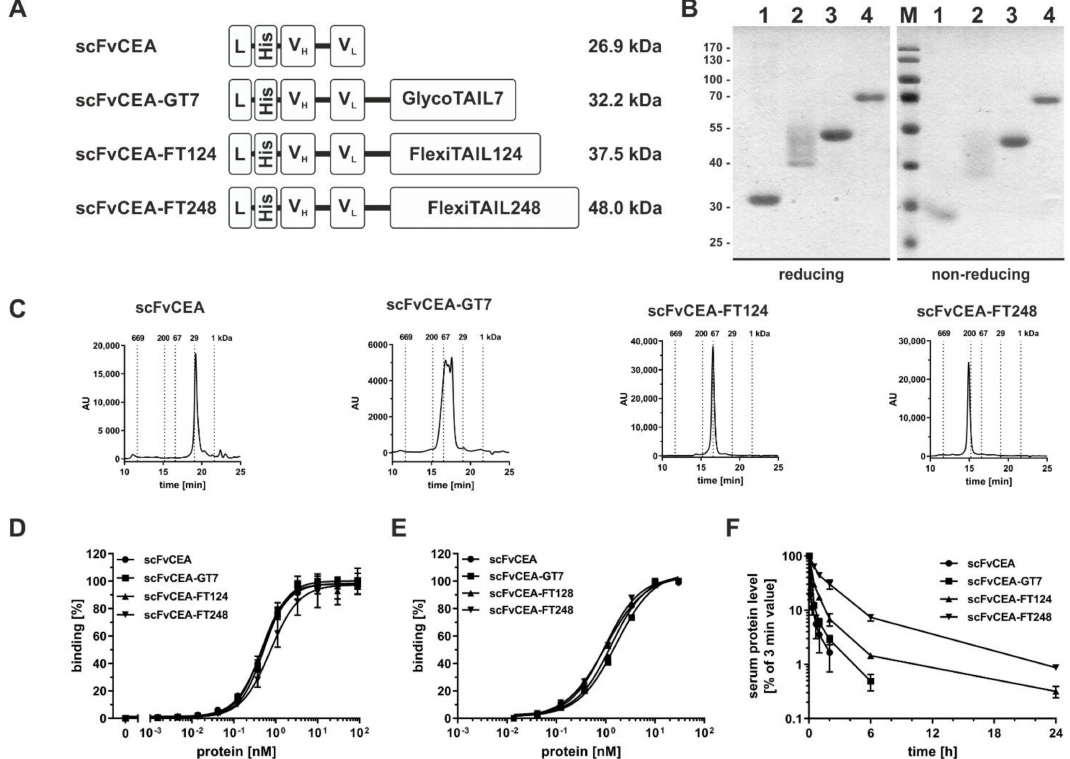
Figure 2. Analysis of scFvCEA-based antibody molecules. ( A ) Schematic illustration of the mono- valent scFvCEA molecules comprising C-terminal GlycoTAIL or a FlexiTAIL moiety and N-terminal a His-tag. ( B ) SDS-PAGE analysis of the purified scFvCEA molecules (1: scFvCEA, 2: scFvCEA-GT7, 3: scFvCEA-FT124, 4: scFvCEA-FT248) under reducing and non-reducing conditions in a 12% ( m / v ) acrylamide gel (3 µ g were loaded per lane; M: marker). ( C ) Size-exclusion chromatography of puri- fied scFvCEA molecules. ( D ) Binding of different monovalent scFvCEA molecules to immobilized CEA in ELISA. ( E ) Cell binding of the different scFvCEA molecules to the colon cancer cell line LS147T determined by flow cytometry. Bound antibodies were measured using a PE-conjugated anti-His antibody. ( F ) Pharmacokinetic analysis of different scFvCEA molecules, which were applied intravenously into immunocompetent CD1 mice. Protein amount of blood samples was